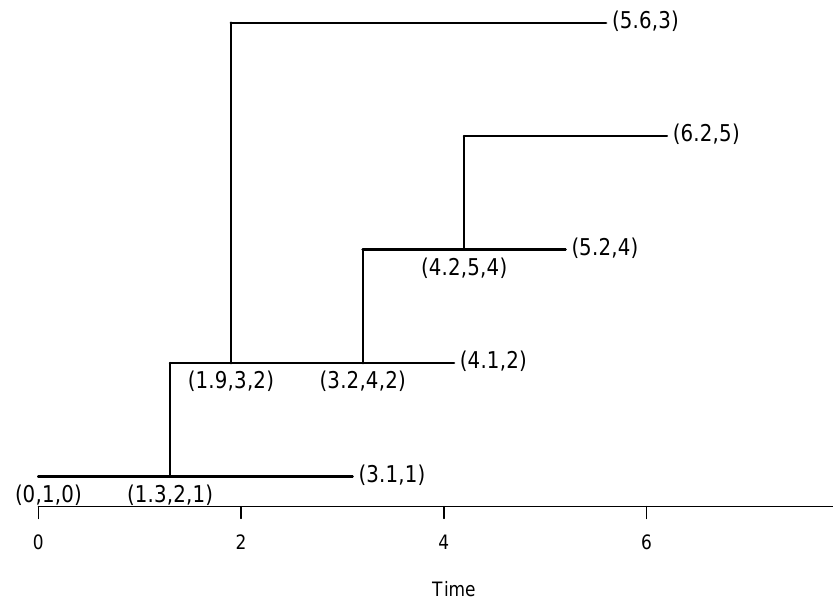
Figure 2. An example of transmission tree showing the labelling scheme. Five individuals are involved in the epidemic and are labelled 1 , . . . , 5 . The root node is labelled (0 , 1 , 0) to signify that, at time t = 0 , individual 1 was (spontaneously) infected. The internal nodes represent transmission events via a triplet such as (1 . 3 , 2 , 1) showing that, at time t = 1 . 3 , individual 2 was infected by individual 1. The leaf nodes represent recovery times, for example (3 . 1 , 1) means that, at time t = 3 . 1 , individual 1 recovered. Note that this tree has one “cherry”, formed by the leaves labelled (5 . 2 , 4) and (6 . 2 , 5) , out of a possible maximum of two